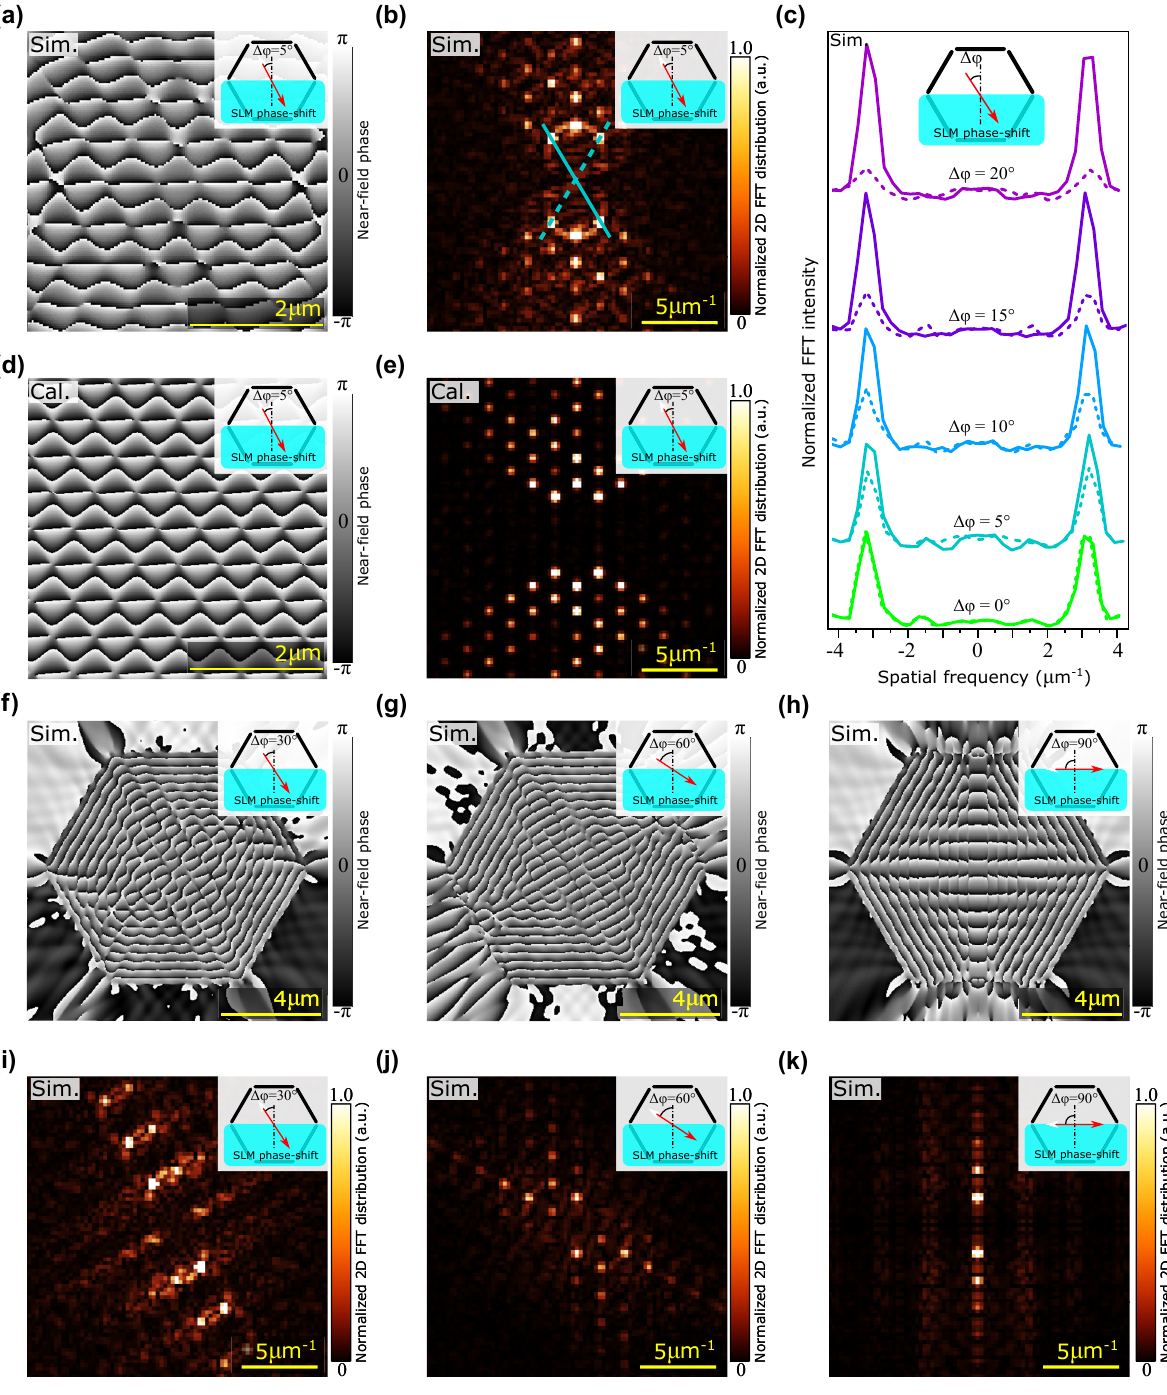
Figure 5: Near-field phase distribution on hexagonal SPID. Hexagonal SPID with three upper slits producing the OBJ wave and bottom three slits producing the REF wave for several polarizations of the illumination wave: FDTD numerical simulation (a) and analytical model (d) with the corresponding FTs (b), (e). Numerical simulations of the phase distribution for several other polarizations of the illuminating wave (f)–(h) with the corresponding FTs (i)–(k). The plot of the most frequent modulations from FTs (c) for several polarizations of the illuminating